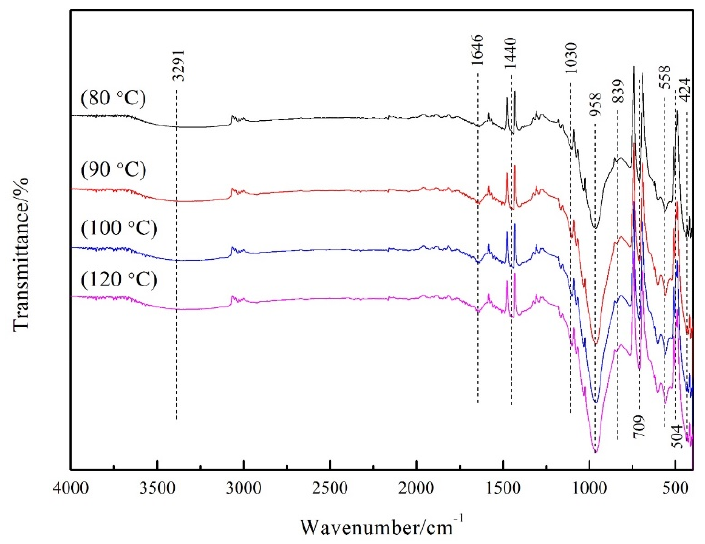
Figure 2. FT-IR spectroscopy of the HAP-ZE synthesized at the different reaction